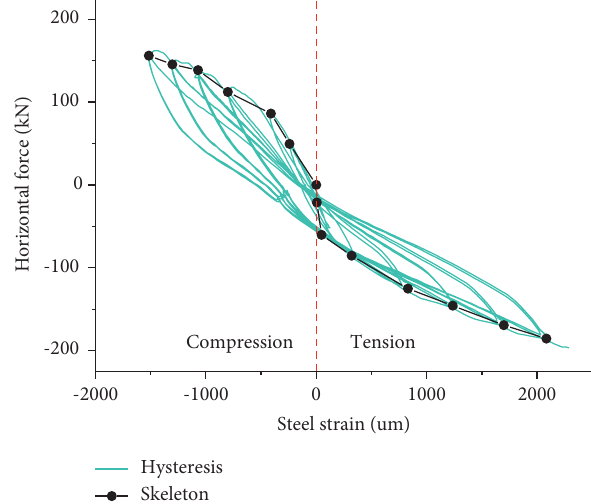
Figure 19: Hysteresis and skeleton curves of rebar strain in